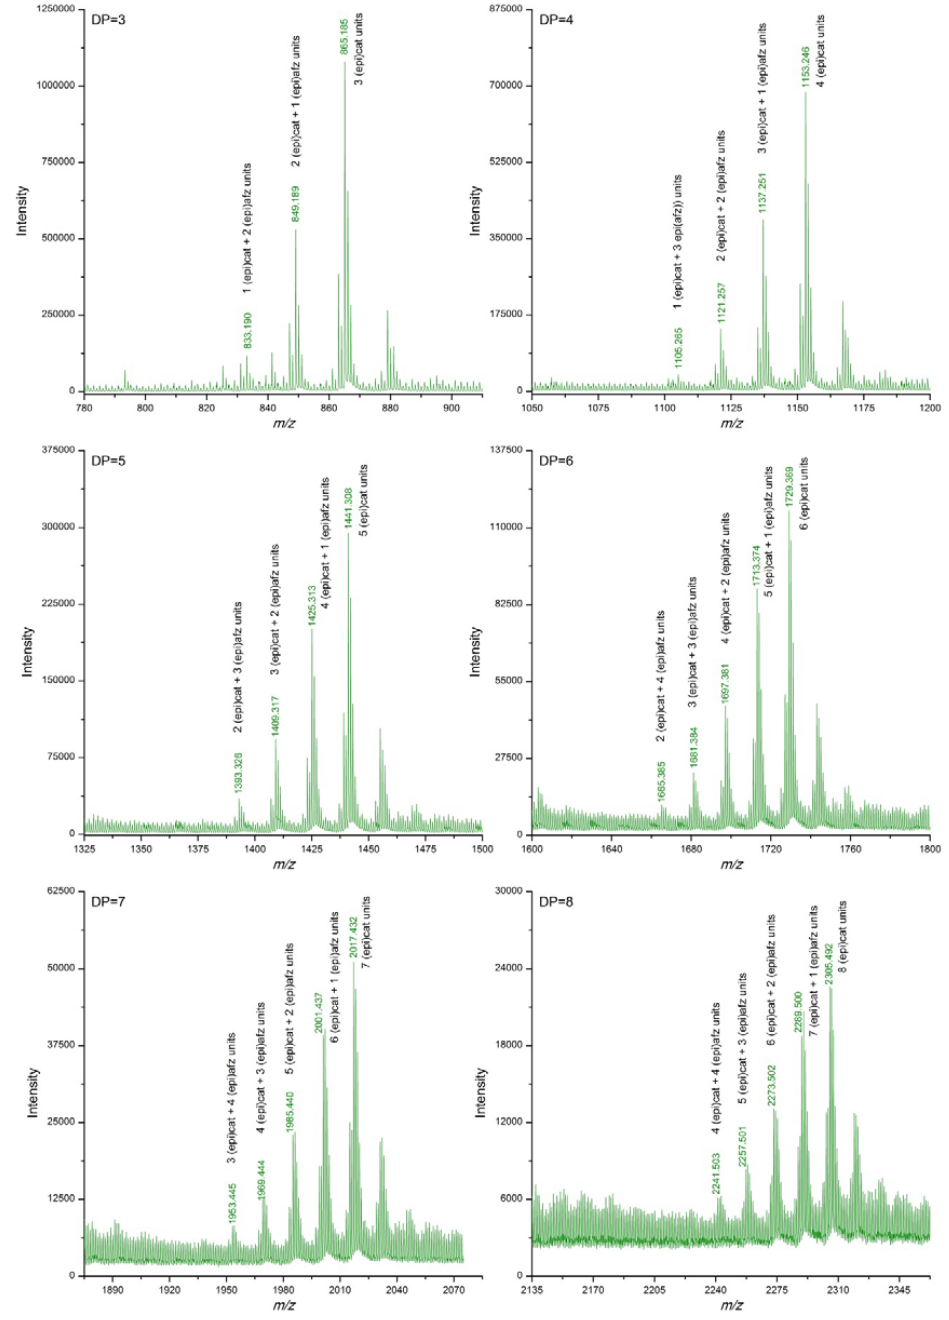
Figure 3. Enlargements of DI-ESI-QTOF mass spectrum of proanthocyanidins with DP 3–8 from a sample of U. tomentosa stems from Sarapiquí